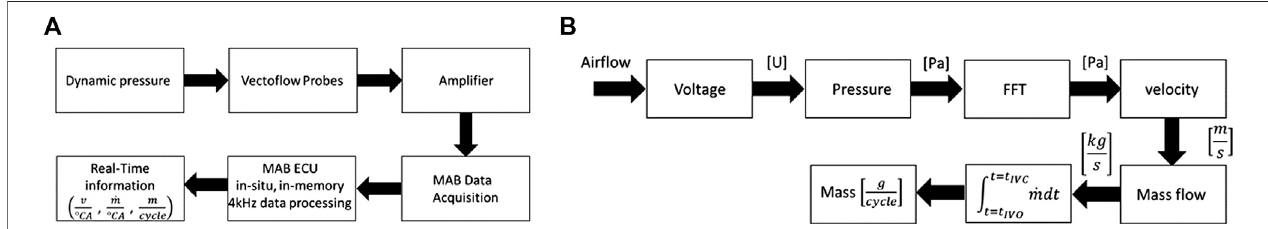
FIGURE 3 | (A) signal chain and (B) signal processing of the